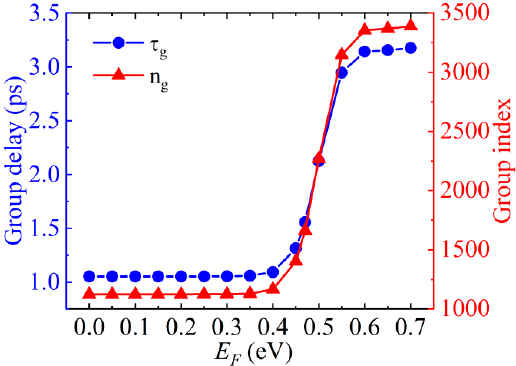
Figure 8. Group delay and index at the EIT resonance as a function of the Fermi level.